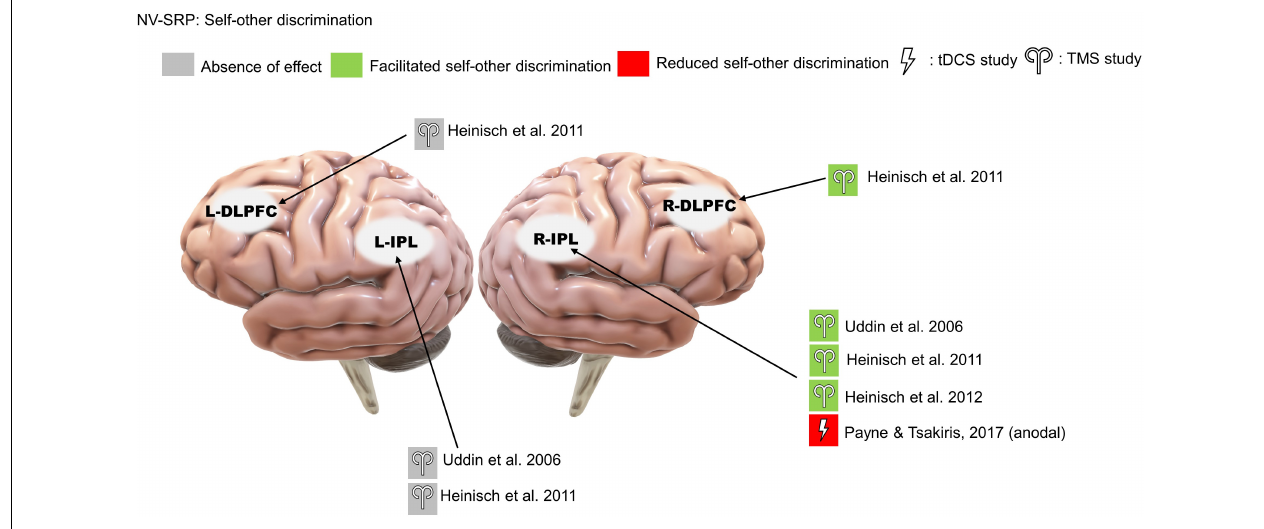
FIGURE 5 | Results of the reviewed studies on NV-SRP with tasks involving self-other